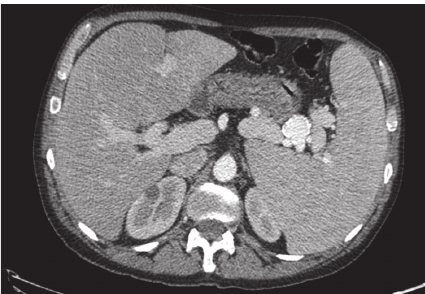
Figure 1: CT scan of the abdomen using IV contrast, performed before aneurysm embolization. A markedly enlarged spleen and a saccular aneurysm of the splenic artery with calcified walls are seen. A significant portal vein dilation with an increased splenoportal axis calibre is also